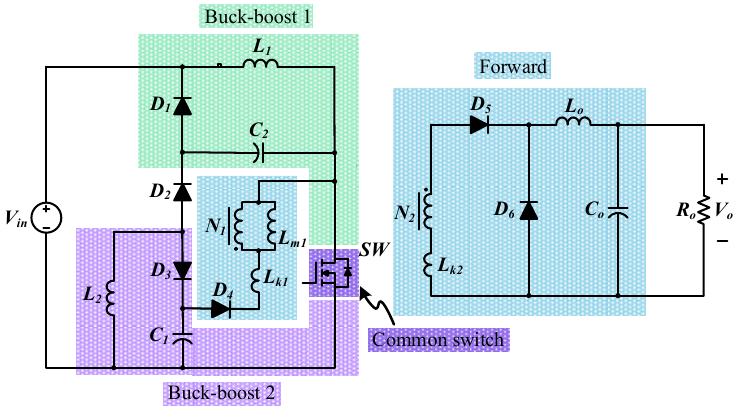
Figure 3. The main power circuit of CHSDC.